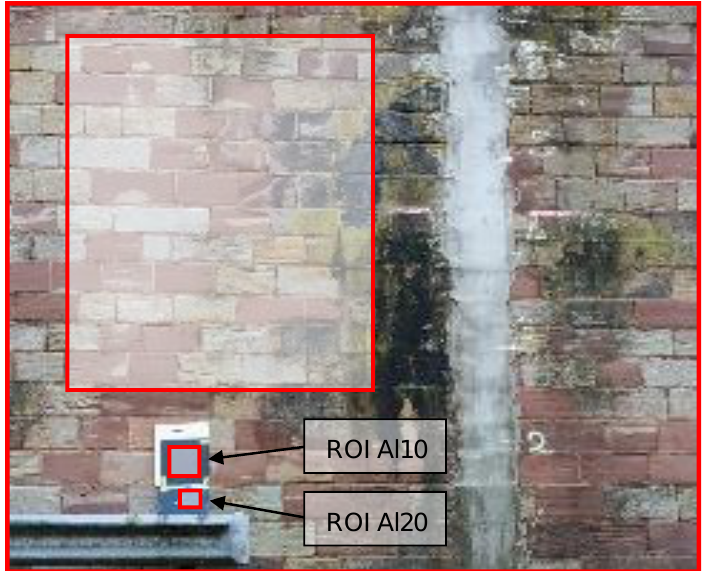
Figure 6. ROI location and size. In the lower left are the two reference plates (aluminum plates, each 300 × 300 mm size, one 10 mm, the other 20 mm thick). On the right side, a plaster strip is visible from earlier experiments on the wall.